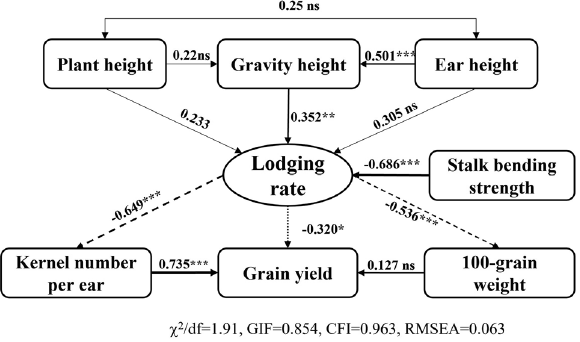
Figure 5. Path analysis of maize grain yield, yield component, SBS and plant architecture